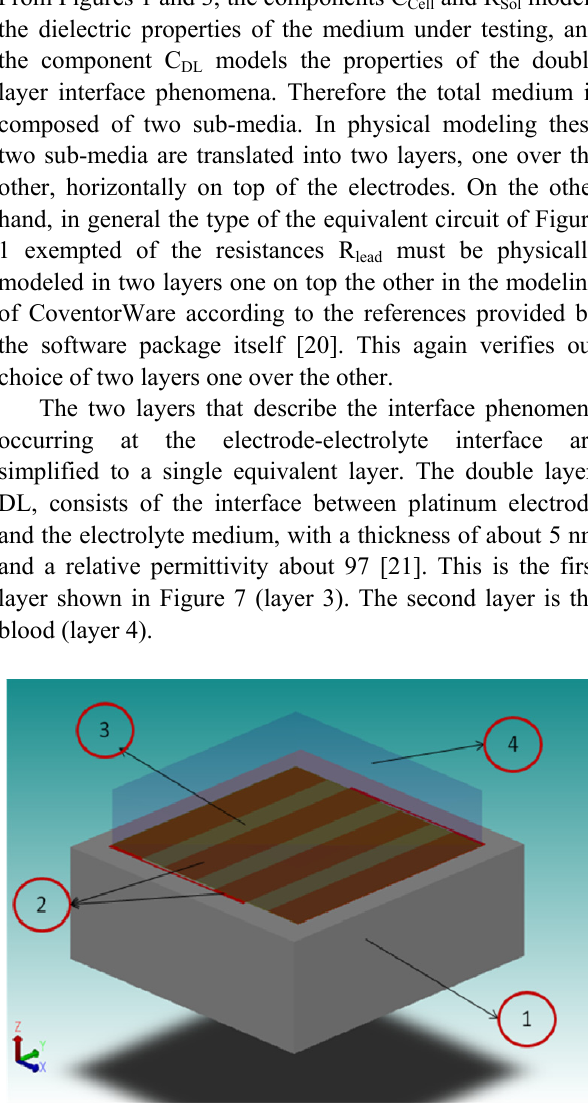
Fig. 7: 3D view of structural model of 4 electrodes type planar interdigitated electrode array (layer 2) loaded by the full medium, which contains the double layer DL (layer 3) and blood medium (layer 4). The entire system is located on a glass substrate (layer 1). The width W and spacing S of electrodes in this figure is 167 μ m and 111 μ m, respectively. The size of full medium is 1000×1000×500 μ